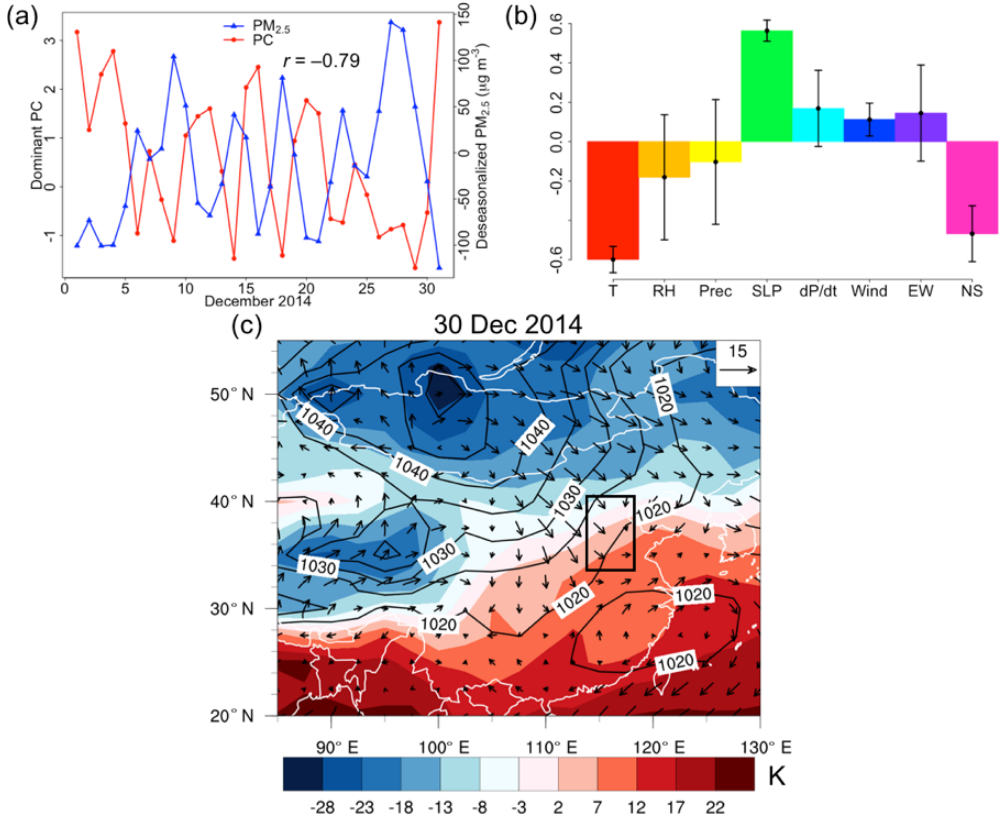
Figure 3. Annually dominant meteorological mode for observed PM 2 . 5 variability in Beijing–Tianjin–Hebei (BTH). (a) Time series of deseasonalized observed total PM 2 . 5 concentrations and the principal component (PC) time series in the sample month of December 2014. (b) Composition of this mode as determined by the coefficients α kj , with error bars showing 2 standard deviations of the eigenvector coefficients. Meteorological variables are listed in Table 1. (c) Synoptic weather map on 30 December 2014 with temperature (K) as shaded colors, wind speed (ms − 1 ) as vectors, and sea level pressure (hPa) as contours. The rectangle indicates BTH. The weather map, which shows an example of positive influence of the mode, is plotted using NCEP/NCAR reanalysis I